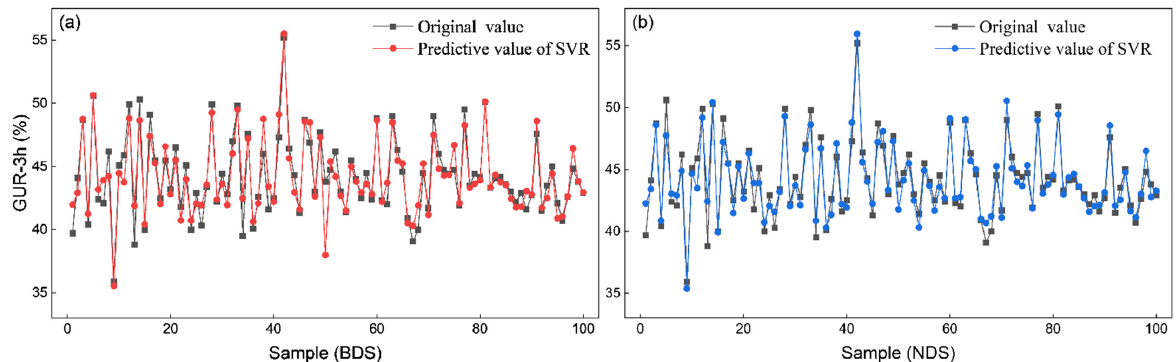
Figure 10. The prediction results of the SVR model separately based on BDS ( a ) and NDS ( b ) (the forecasting parameter is the GUR-3h).